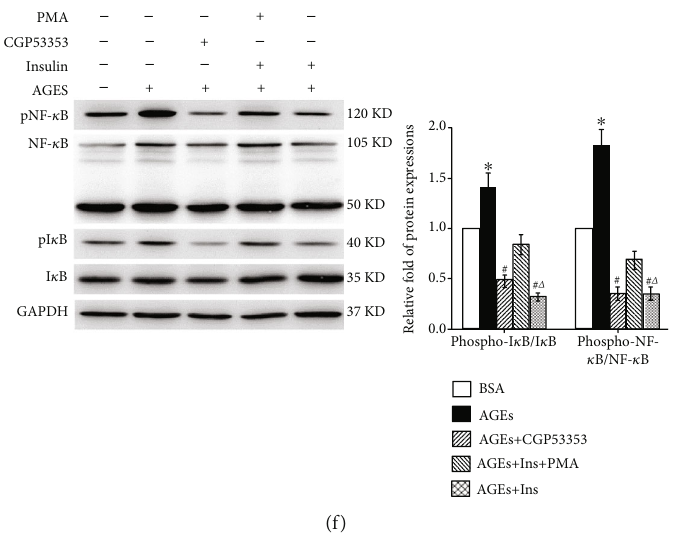
Figure 5: PKC β 1 played a critical role in AGEs-BSA-stimulated BMDCs immune maturation. (a) Flow cytometric analysis was performed for cell surface CD83, CD86, and MHC-II expression examinations. CGP53353 attenuated AGEs-BSA-induced CD83 and CD86 upregulation; (b) the concentrations of TNF- α , IFN- γ , IL-6, IL-1b, and CCL2 in the supernatants of the culture were measured by ELISA; (c, d) the expressions of cytokines and chemokines mRNA in BMDCs were analyzed by real-time quantitative RT-PCR. CGP53353 attenuated proin fl ammatory cytokine and chemokine secretion in BMDCs and upregulated the expression of IL-10; (e, f) the expressions of NF- κ B, I κ B, phosphorylated PKC β 1, and serine phosphorylated IRS1 were determined by western blot in the presence of PMA or CGP53353. The phosphorylation of NF- κ B and I κ B were downregulated following direct PKC β 1 inhibition. In addition, the serine phosphorylation of IRS1 was found to decrease upon direct PKC β 1 inhibition. Data are expressed as mean ± SED ; n = 5 ; ∗ p < 0 : 05 vs. control group; # p < 0 : 05 vs. AGEs-BSA group; Δ p < 0 : 05 vs. AGEs + Insulin + PMA group. AGEs-BSA: advanced glycosylation end-bovine serum albumin; BMDCs: bone marrow-derived dendritic cells; RAGE: receptor for advanced glycation end products; pPKC: phosphorylated protein kinase C; IRS1: insulin receptor subunit-1; TNF- α : tumor necrosis factor- α ; IFN- γ : interferon- γ ; MHC-II: major histocompatibility complex-II; NF- κ B: nuclear factor- κ